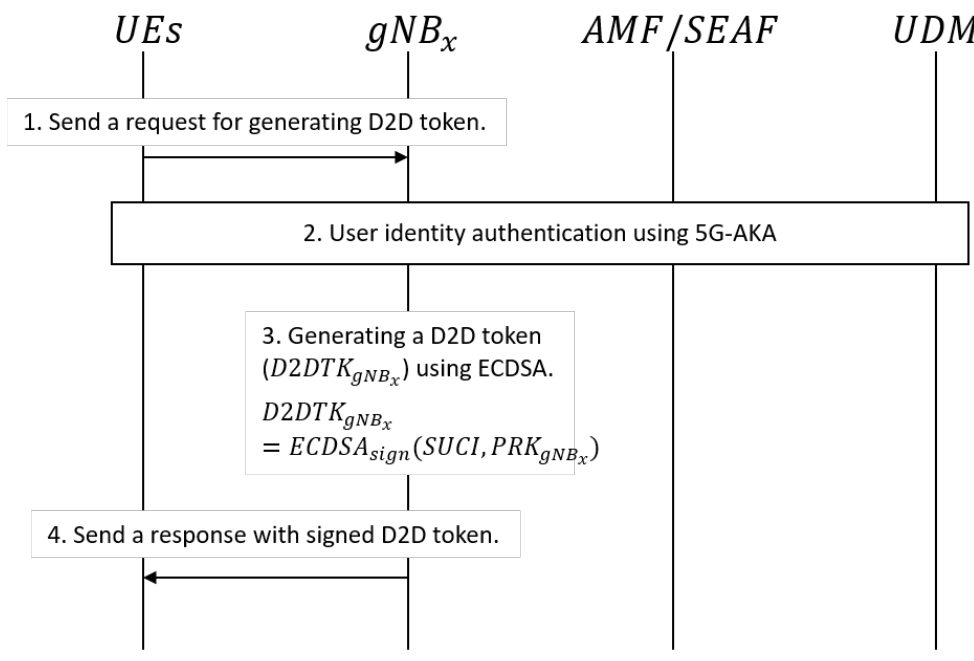
Figure 2. D2D token generation